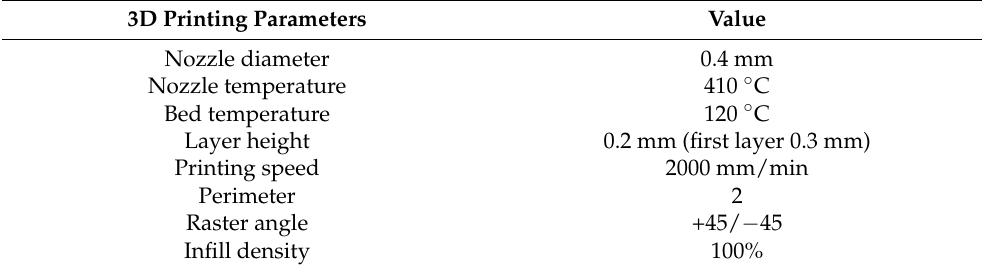
Table 6. 3D printing